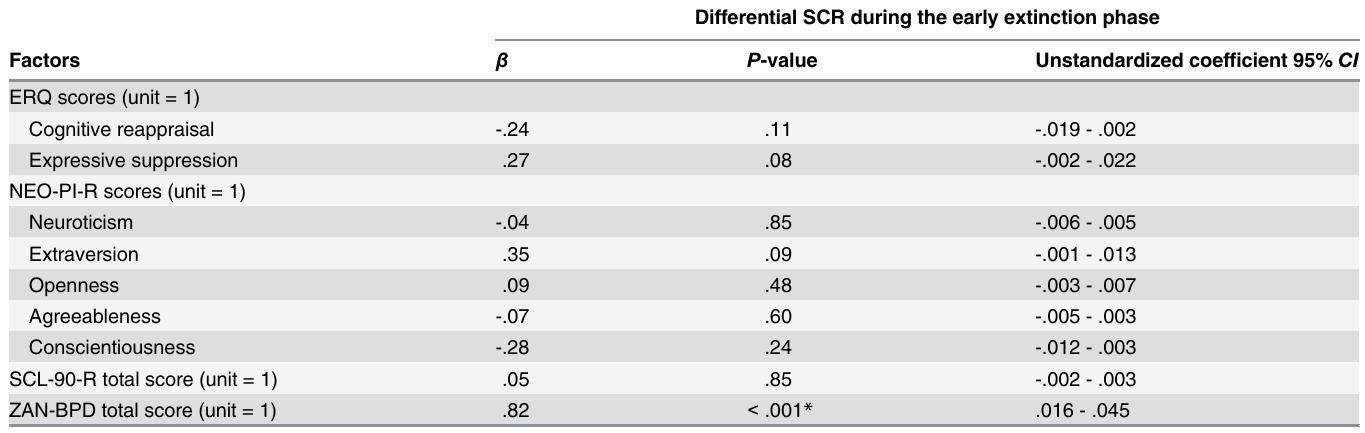
Table 3. Results of multiple linear regression analysis with differential SCR during the early extinction phase as a dependent variable in the inter- personal stimulus condition. Differential SCR during the early extinction